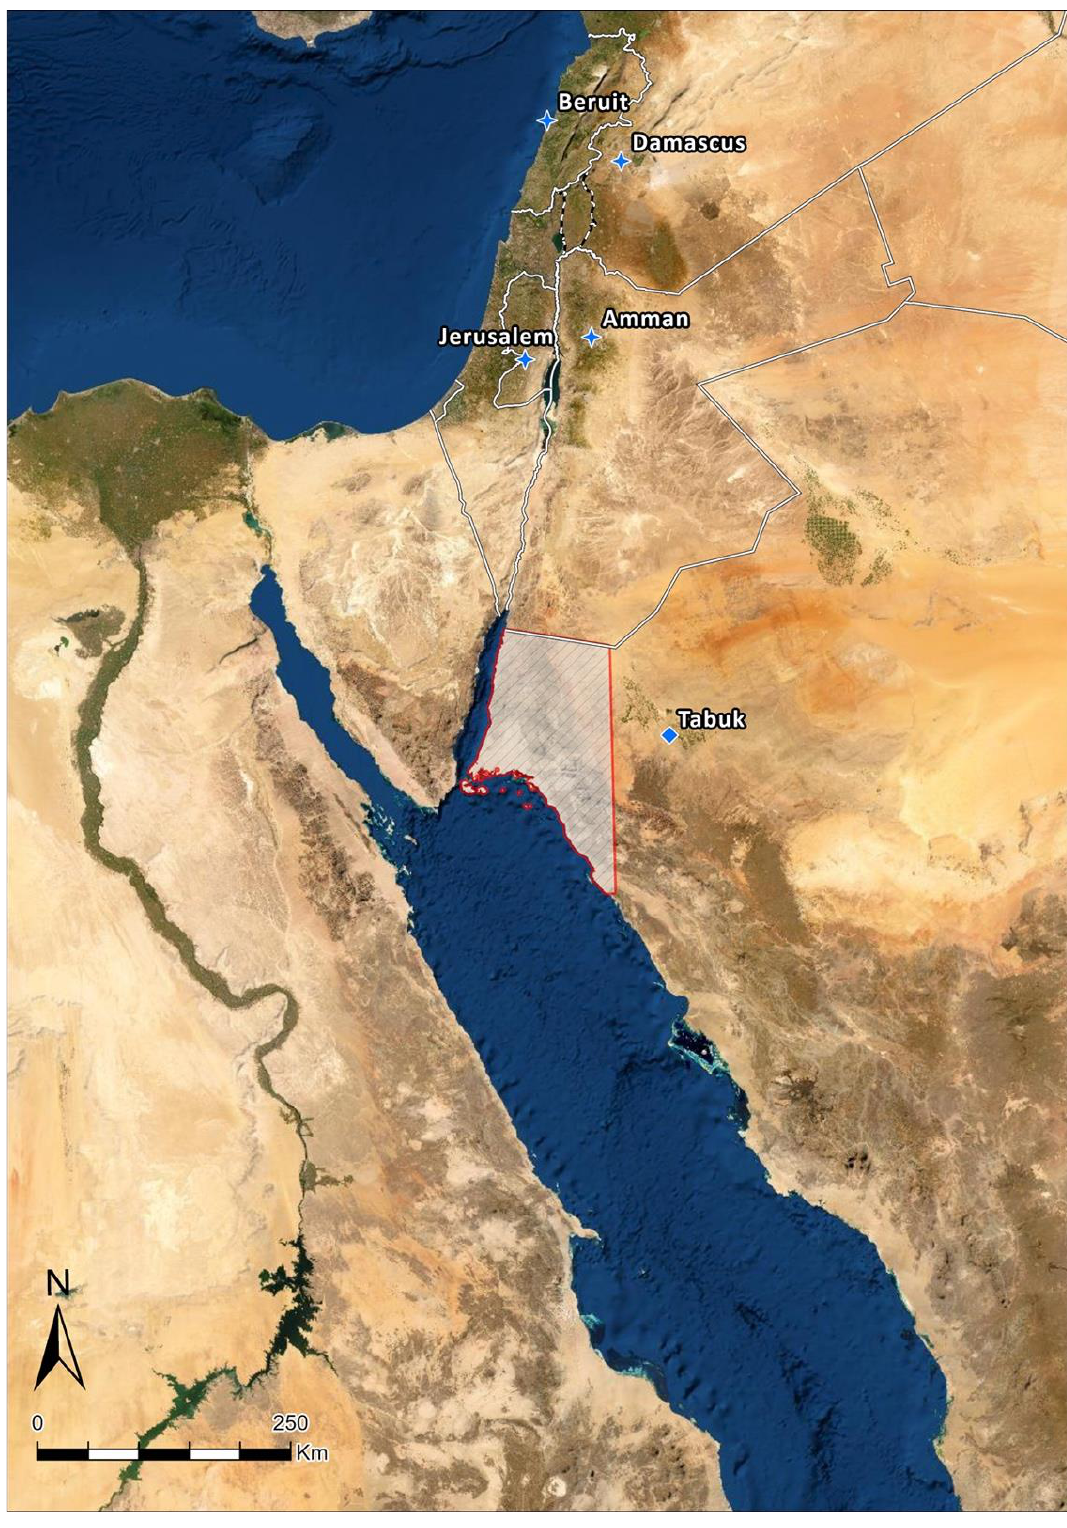
Figure 1. The Neom survey area in regional context.